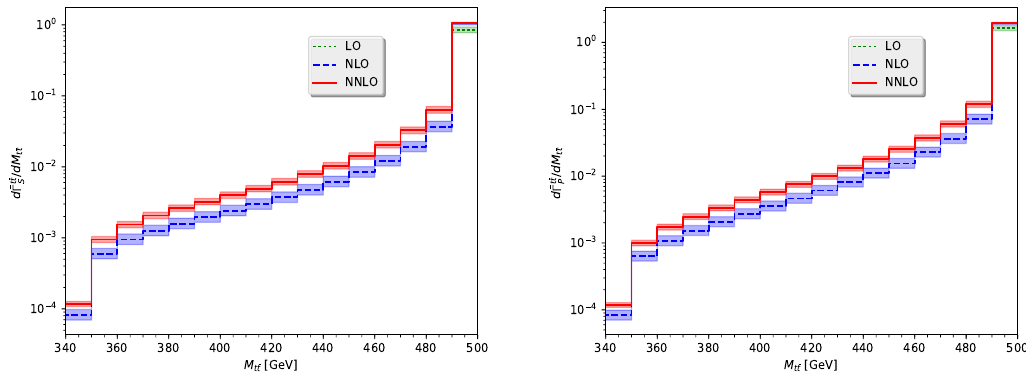
(cid:22) t Figure 4 . Left plot: distribution d (cid:0) t =dM t (cid:22) t invariant mass for a 500 GeV scalar Higgs t (cid:22) t of the S boson with a t = 1 at LO (short-dashed, green), NLO (long-dashed, blue), and NNLO (solid, red) QCD. The short-dashed, long-dashed, and solid lines correspond to the scale choice (cid:22) = m h while the shaded bands show the e(cid:11)ect of varying the renormalization scale between m h = 2 and 2 m h . Right plot: same as left plot, but for a pseudoscalar Higgs boson with b t =